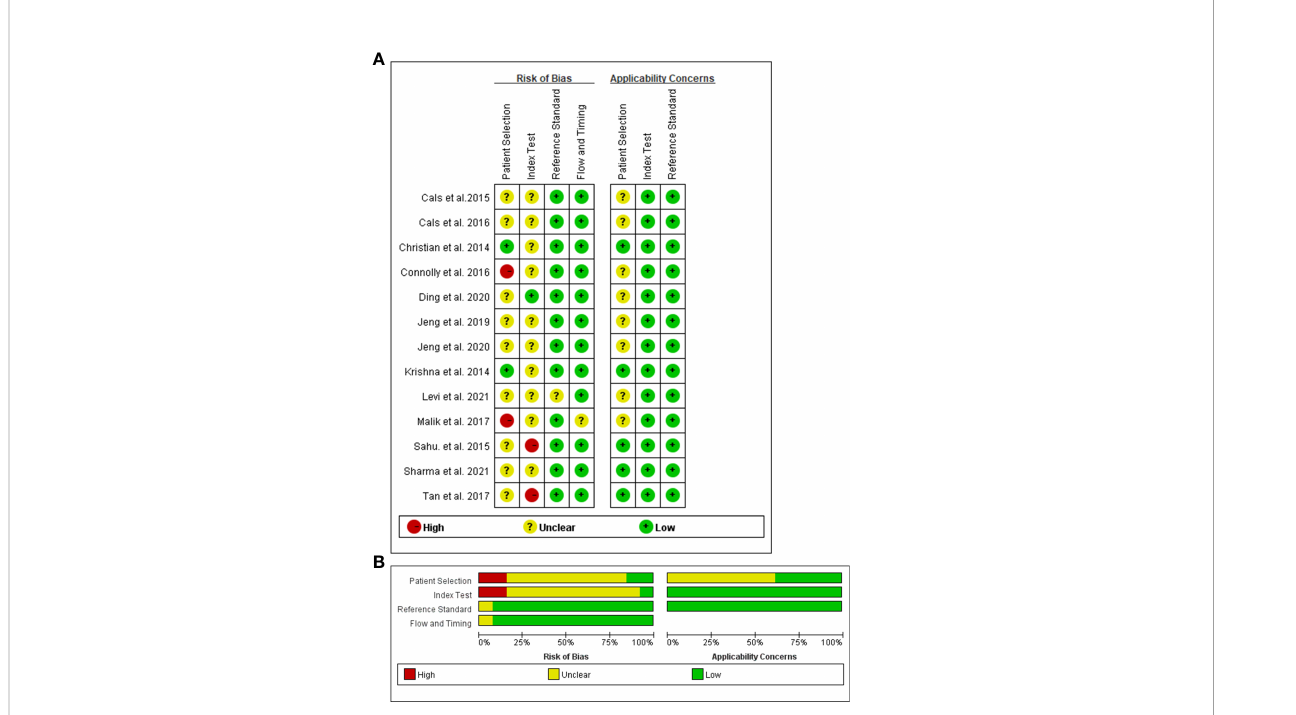
FIGURE 2 Risks of bias assessment for each included study (n = 12). Risk of bias summary (A) . Risk of bias graph (B) .